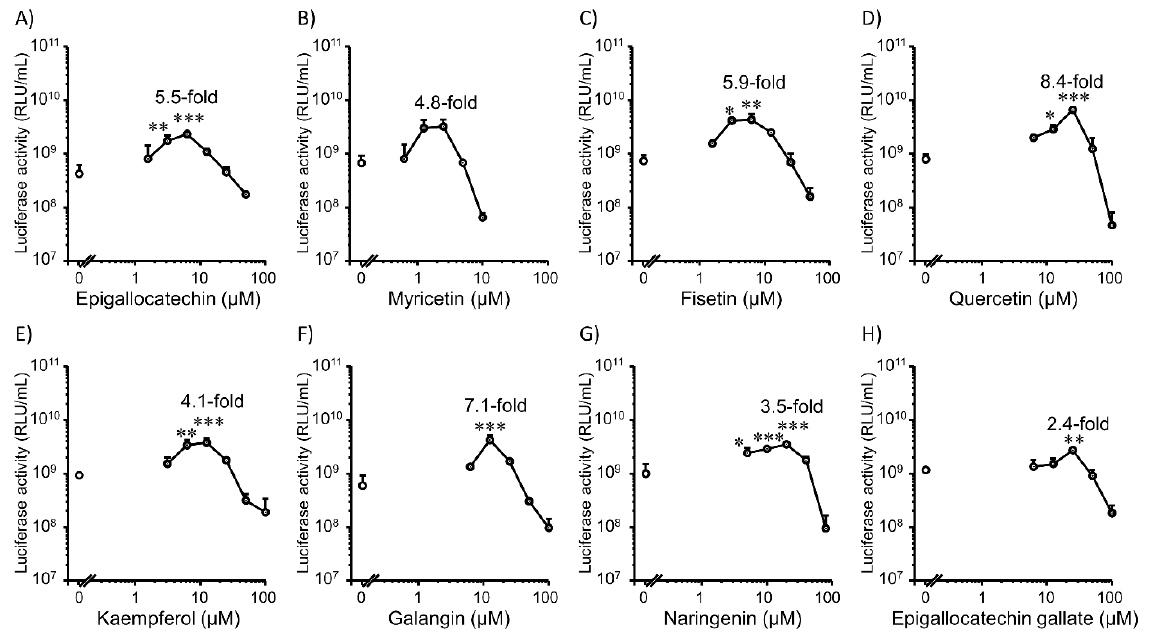
Figure 1. Effect of co-incubation with flavonoids on transfection efficiency mediated by Lipofec- tamine 3000/plasmid DNA (pcDNA3/GL 0.2 µg/well) complexes in 2D Colon26 cells. ( A ) Epigallo- catechin (0–50 µM). ( B ) Myricetin (0–10 µM). ( C ) Fisetin (0–50 µM). ( D ) Quercetin (0–100 µM). ( E ) Kaempferol (0–100 µM). ( F ) Galangin (0–100 µM). ( G ) Naringenin (0–80 µM). ( H ) Epigallocatechin gallate (0–100 µM). Each dot represents the mean + standard deviation (SD; n = 3). * p < 0.05, ** p < 0.01, *** p < 0.001 compared with the control (0 µM flavonoids).